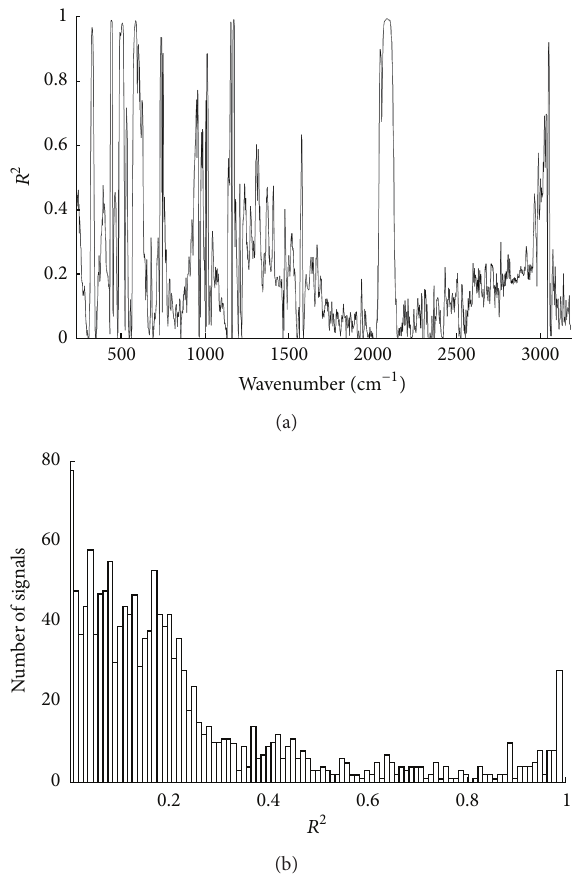
Figure 1: (a) 𝑅 2 values for all signals. (b) Histogram for the 𝑅 2